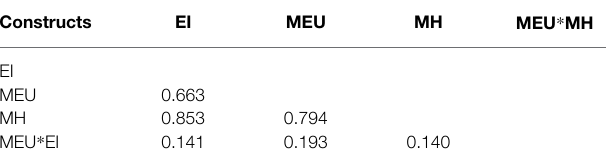
TABLE 2 | Discriminant validity through Heterotrait–Monotrait Ratio (HTMT).